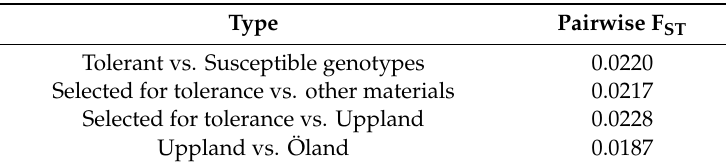
Table 1. Pairwise F ST comparison of ash